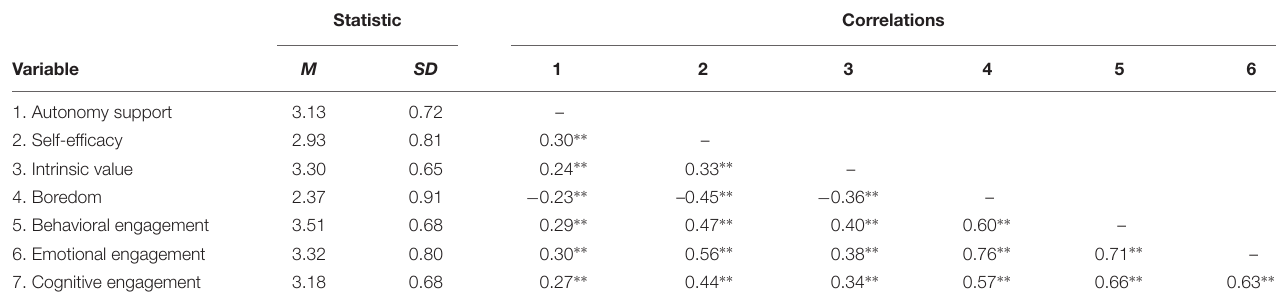
TABLE 1 | Descriptive statistics and correlations for major